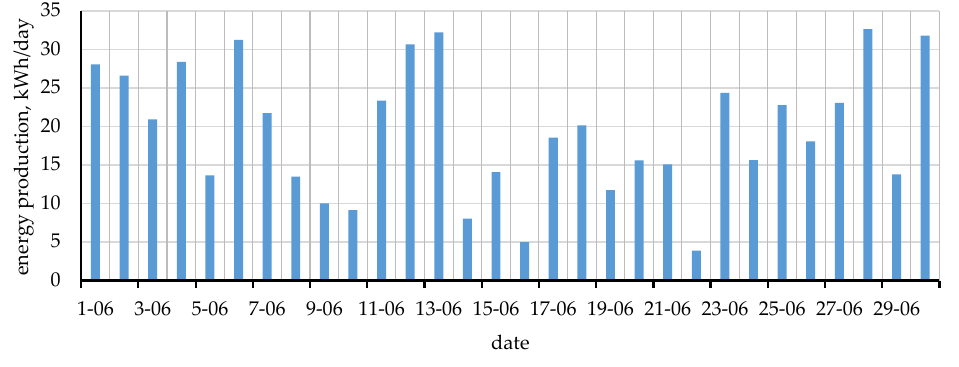
Figure 11. Daily energy production in PV installation (Leki), June 2020. The daily production of bifacial PV installation in Bydgoszcz in June 2020 ranged from 6.4 kWh to 46 kWh (Figure 12). Total production for June was measured as 828.13 kWh ( EMG ).